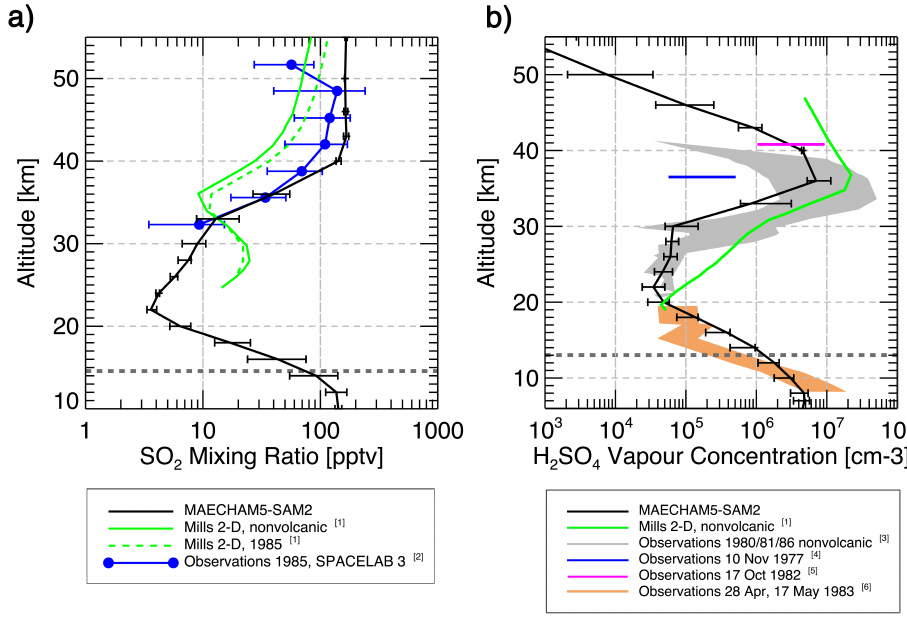
Fig. 3. Vertical profiles of modelled precursor gases in the Northern Hemisphere compared to results by 1 Mills et al. (2005a) and observations from 2 Rinsland et al. (1995), 3 Arnold et al. (1981), Viggiano and Arnold (1981), Schlager and Arnold (1987), and Reiner and Arnold (1997), 4 Arnold and Fabian (1980), 5 Arnold and Qiu (1984), and 6 Heitmann and Arnold (1983). 5 and 6 were conducted in the El Chich´on period and 4 in a near background stratosphere prior the El Chich´on eruption. For MAECHAM5-SAM2 the median of the zonally averaged climatological monthly means of the stratospheric background period 1996–2006 are shown, respective minima and maxima are represented as deviation from the median. Mills et al. (2005a) data for nonvolcanic conditions refer to years prior El Chich´on. (a) SO 2 mixing ratio for April and May from 26 to 32 ◦ N. (b) H 2 SO 4 vapour concentration for June, September and October at 43 ◦ N. In both figures the modelled tropopause height is marked by a dashed gray line.